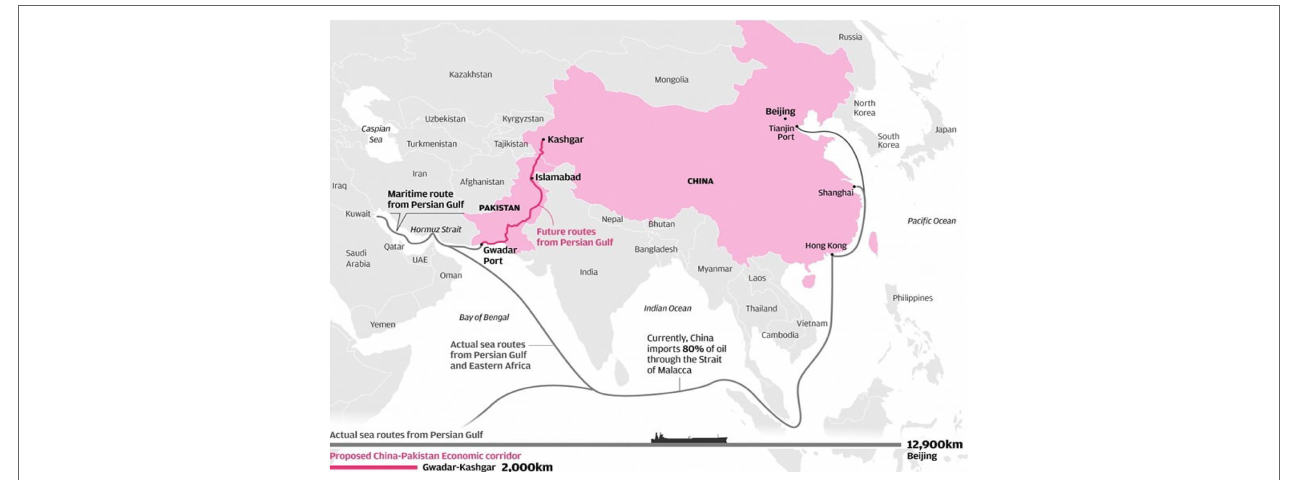
FIGURE 3 | Map of the Maritime Silk Road with New Shortest Route through CPEC. Source: The Dawn (Ebrahim,